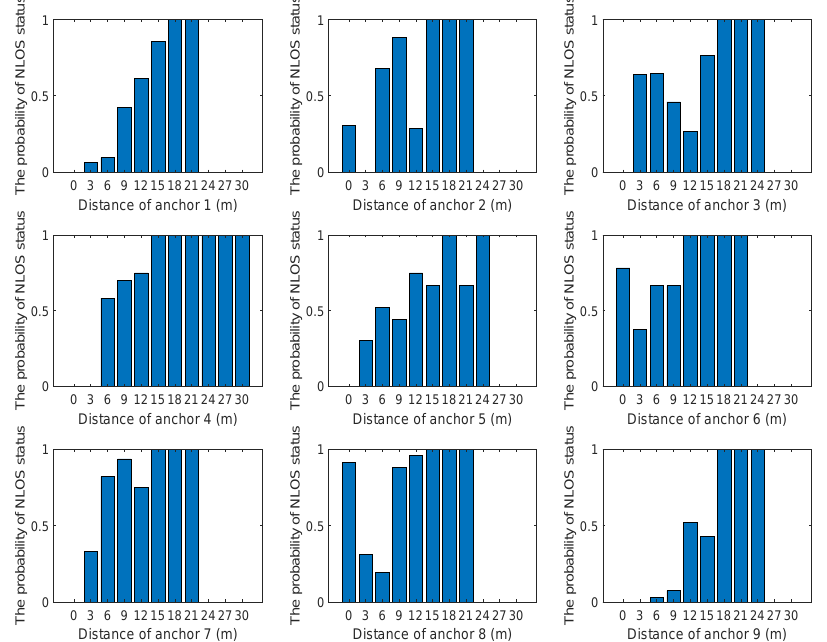
Figure 7. The relationship between distance and NLOS status probability. The horizontal axis of each graph represents distance (m) and the vertical axes represent NLOS status probability.